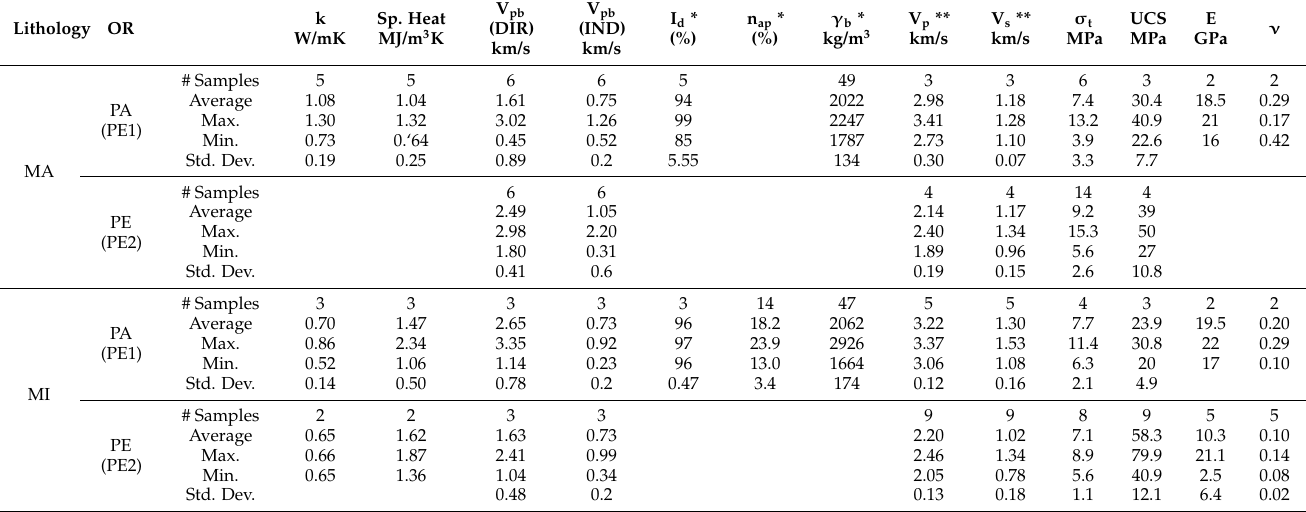
Table 4. Statistical values of the tested geotechnical parameters for the marly (MA) and